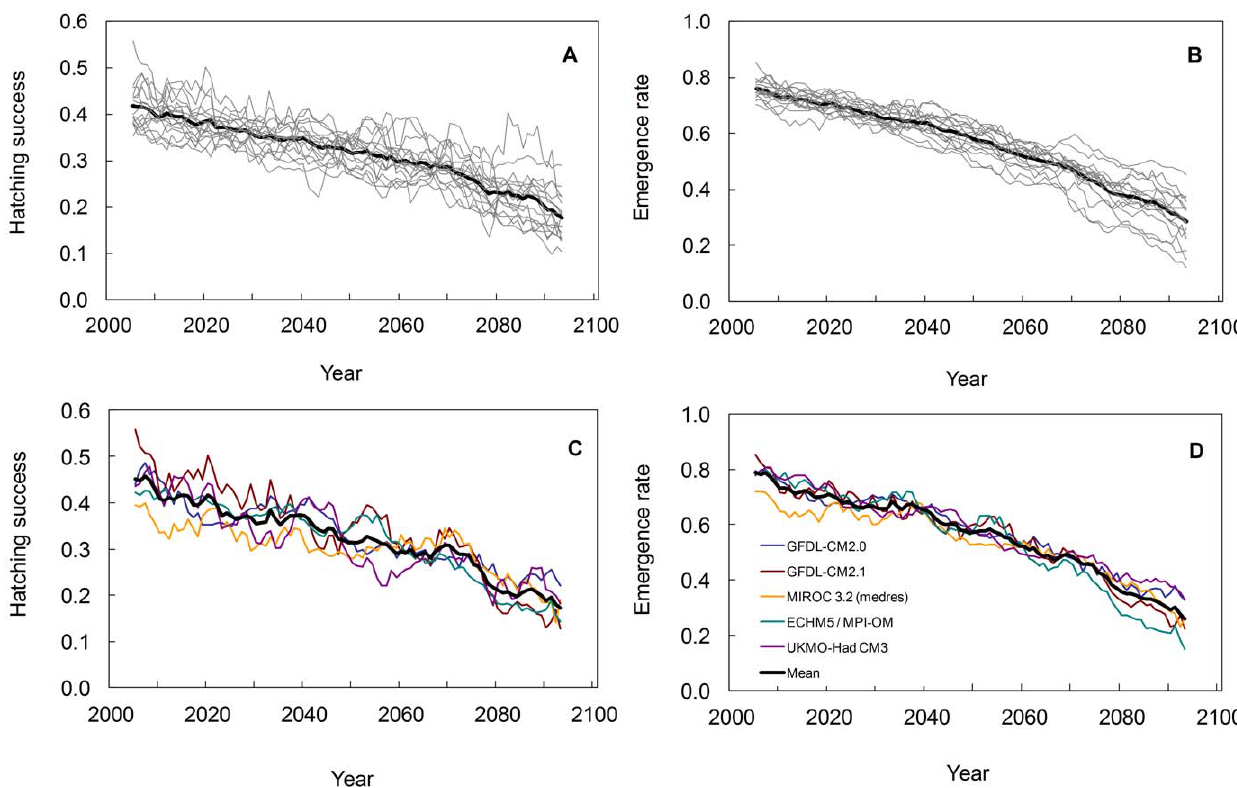
Figure 4. Hatching success and emergence rate projections of leatherback nests in 100 years of climate change. Projections are based on (a,b) each of the 17 bias-corrected CMIP3 models (grey lines) and the ensemble mean (black line) and (c,d) 5 of the bias-corrected CMIP3 models that are skilful at resolving present-day ENSO variability (coloured lines) and their ensemble mean (black line). Time-series projections are presented as 10-year moving